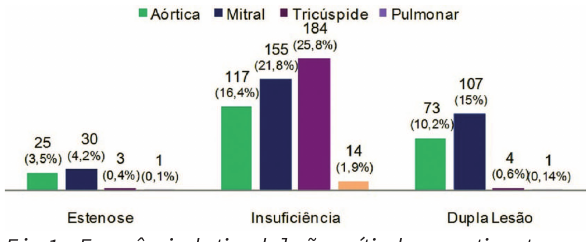
Fig. 1 – Frequência do tipo de lesão e sítio de acometimento Fig. 2 – Gravidade da lesão